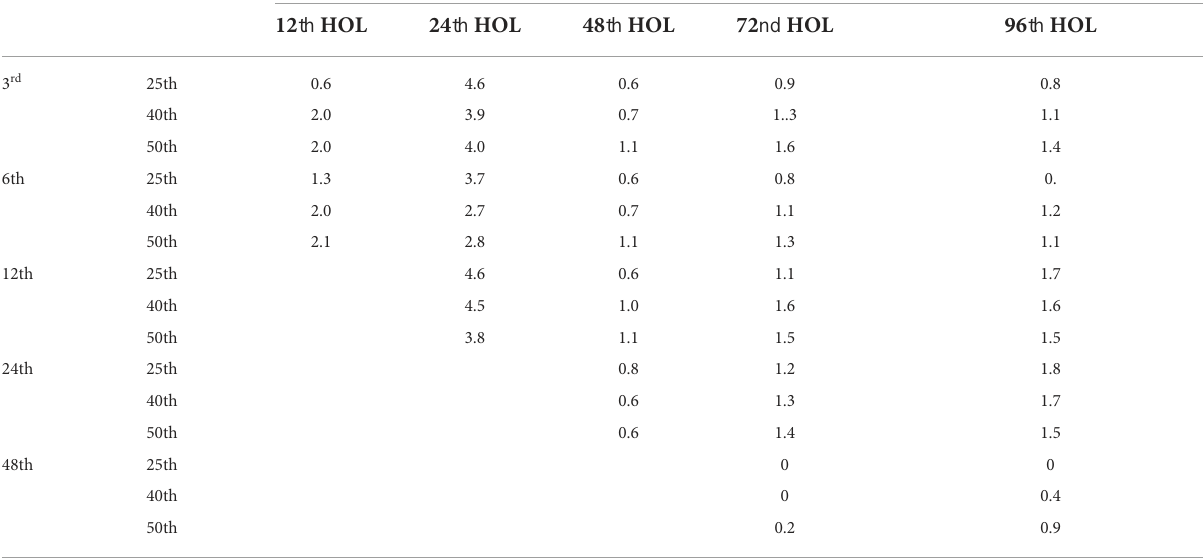
TABLE 2 Comparison of different bilirubin percentiles (25th, 40th and 50th) and frequencies of developing significant hyperbilirubinemia ( ≥ 95th percentile) at different time points. HOL Percentiles Frequency (%) of significant hyperbilirubinemia at different time periods 12 th HOL 24 th HOL 48 th HOL